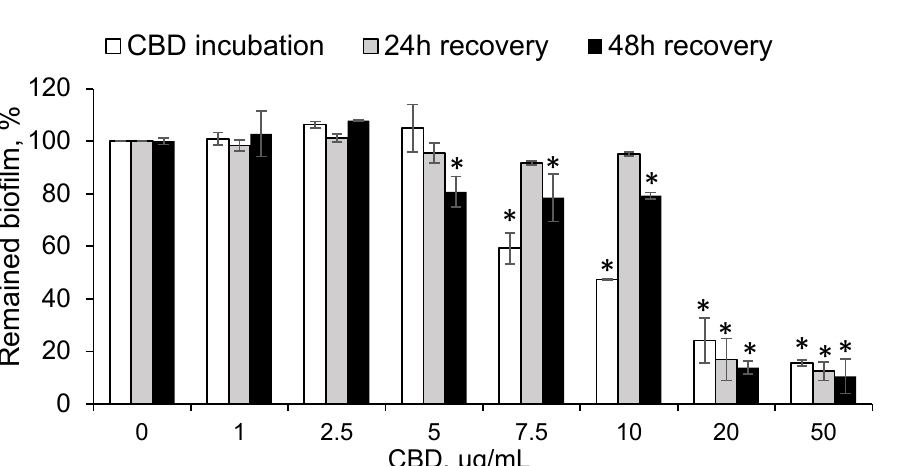
Figure 4. CBD shows prolonged anti-metabolic effect on preformed S. mutans biofilms. S. mutans were allowed to form a biofilm for 24 h, and then exposed to various concentrations of CBD for another 24 h (white column). Thereafter, CBD was removed, and the biofilms were further incubated in BHI with sucrose for another 24 h (grey column) or 48 h (black column), and the metabolic activity of the biofilm-embedded bacteria was measured by MTT assay at each time point. The average and SEM from a representative experiment are presented. * p < 0.05 in comparison to the control of the same time point.